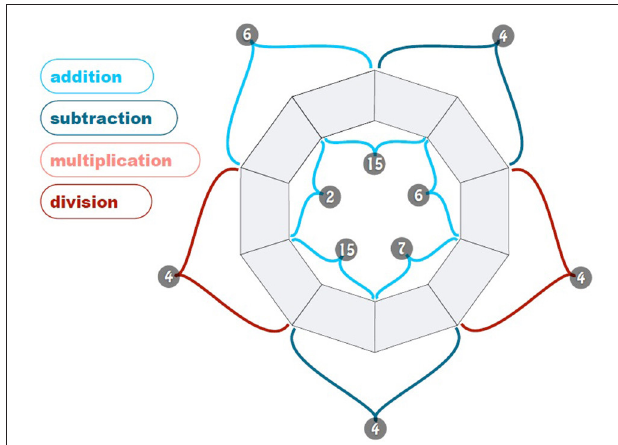
FIGURE 3 | Sample pollinator